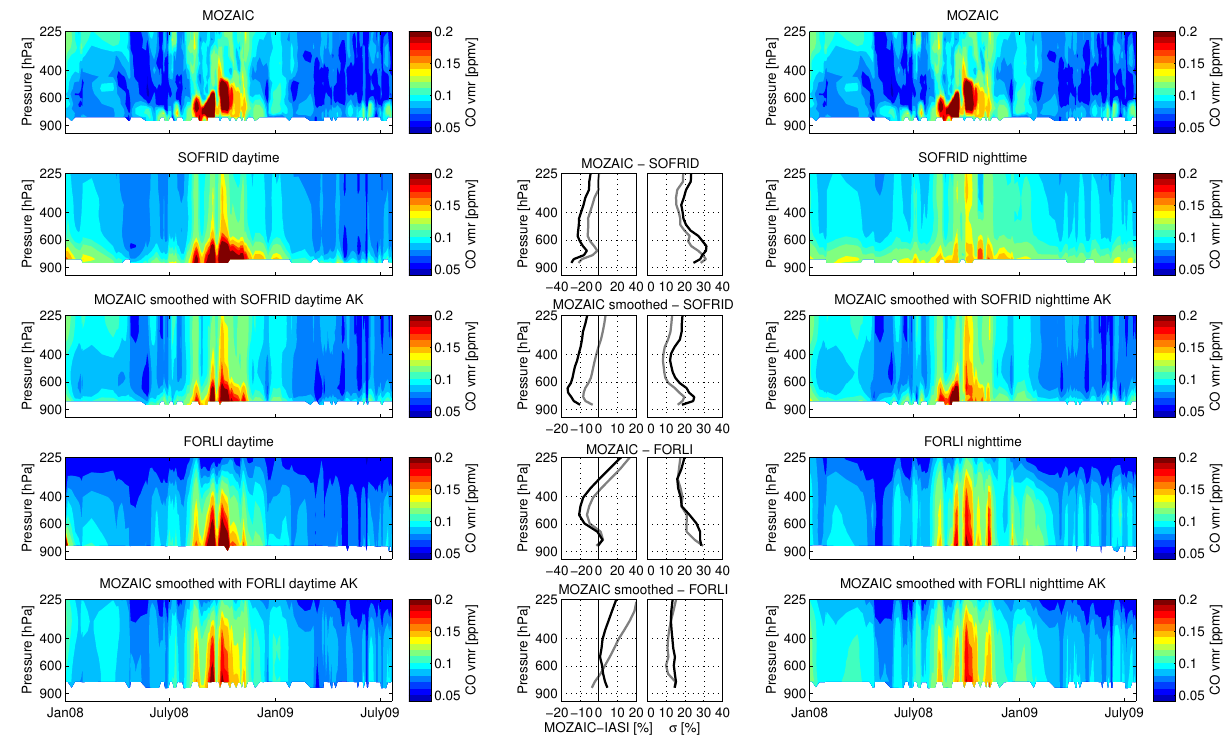
Fig. 8. As Fig. 7 for Windhoek from January 2008 to July 2009.